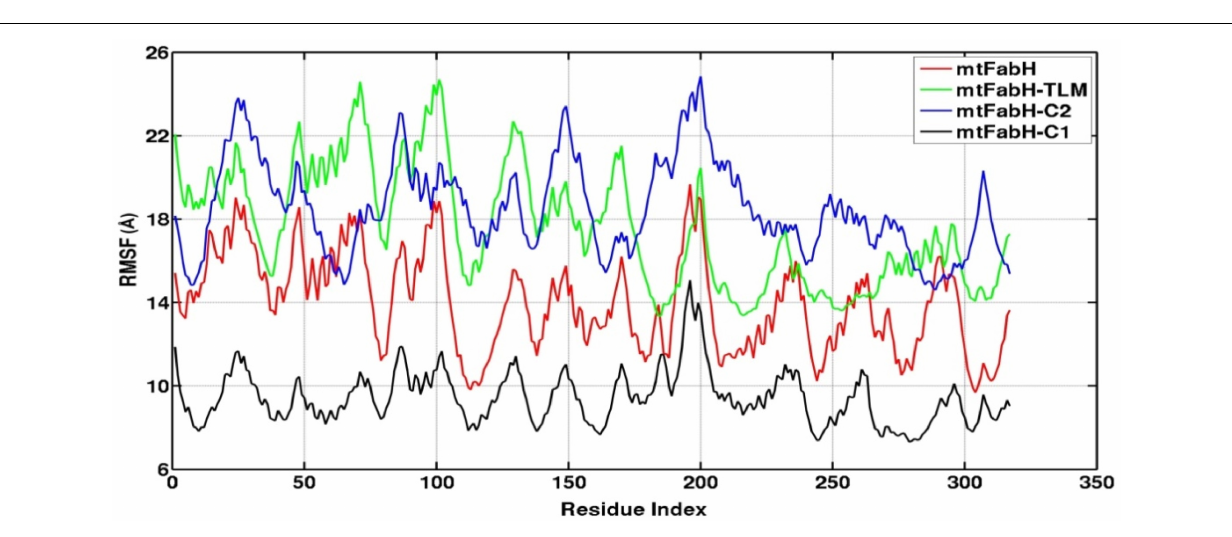
FIGURE 10 | Root mean square fluctuation (RMSF) plots of mtFabH and docked complexes with ligands, TLM, C2, and